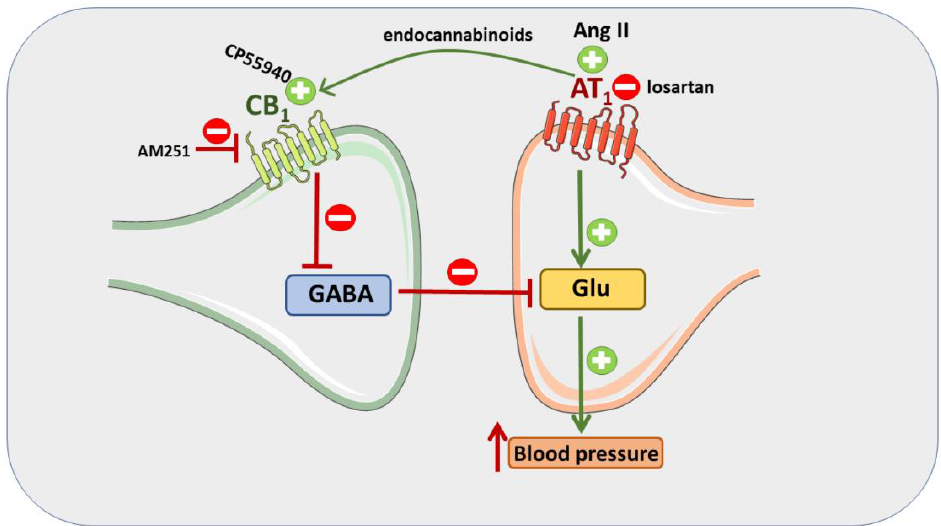
Figure 8. Mechanisms involved in the pressor response induced by Ang II and CP55940. Ang II, via AT 1 receptors, leads to endocannabinoid formation in the paraventricular nucleus of hypothalamus (PVN). Endocannabinoids in turn inhibit GABA release by activation of CB 1 receptors. Since little GABA is released, much glutamate (Glu) can be released, also since facilitatory AT 1 receptors on the glutamatergic neuron further increase Glu release. The extents of Glu release and of the pressor response are correlated. The pressor response in SHR increased since AT 1 and CB 1 receptor density in their PVN increased. On the other hand, the pressor response induced by Ang II can be attenuated by CB 1 receptor antagonist AM251. In addition, the pressor response induced by the CB 1 receptor agonist CP55940 can be antagonized by AT 1 receptor antagonist losartan.